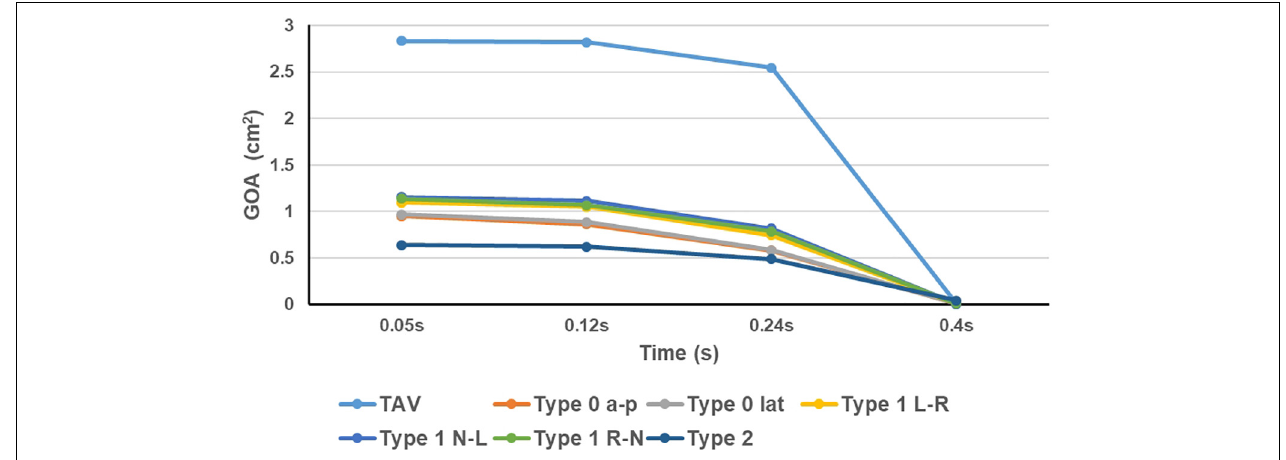
FIGURE 6 | Dynamic variations of GOA of TAV and BAV models.